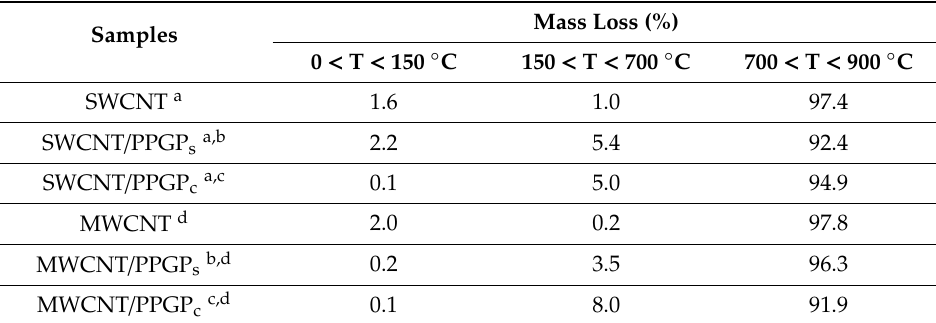
Table 1. Mass losses for CNT and CNT / PPGP adducts from TGA